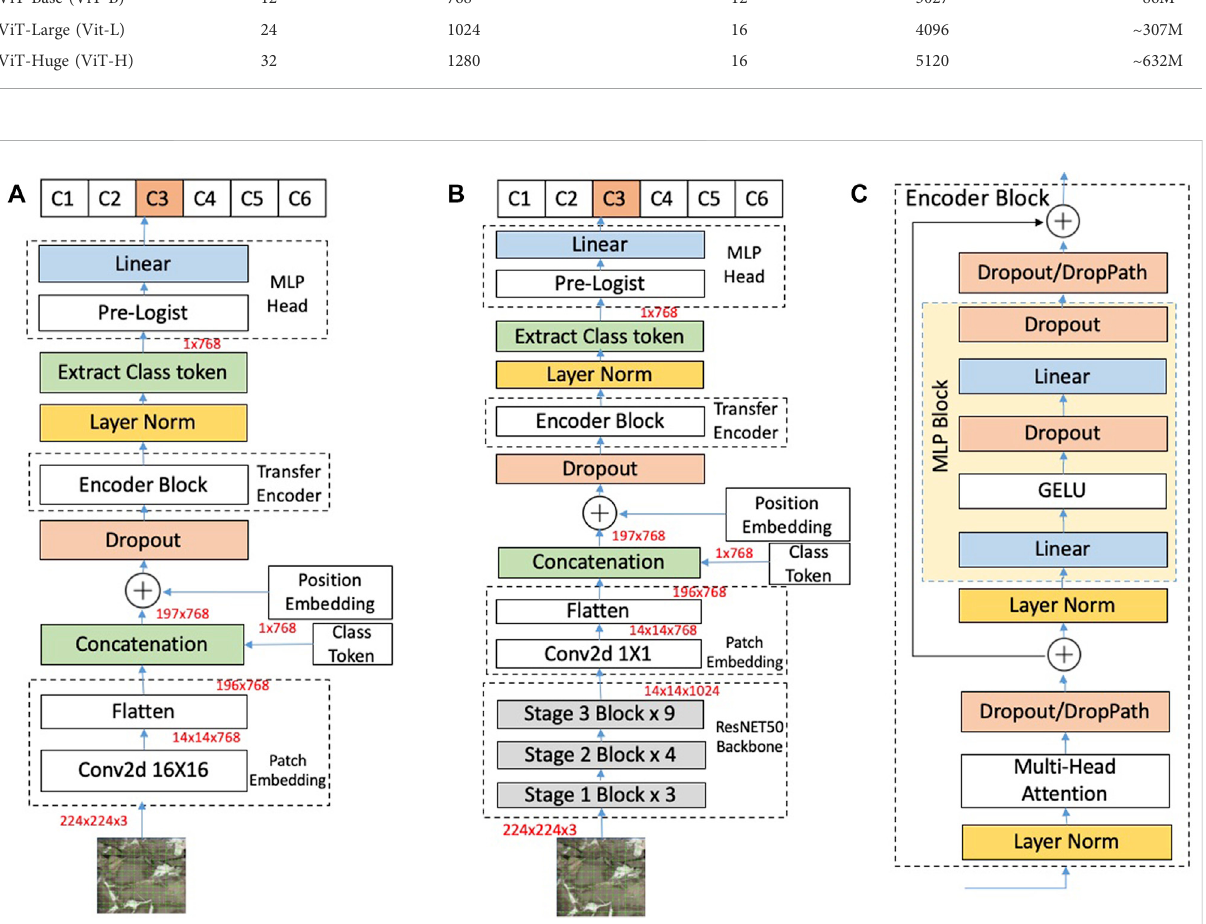
FIGURE 2 AnoverviewofVisionTransformerarchitecture: (A) FaciesViT, (B) thehybridResNetandViTarchitecture,and (C) theencoderblock.Theoutput layer is represented by Classes from C1 to C6 where C1: Argil, C2: Granit, C3: limestone, C4: Standstone lam, C5: Standstone mas, and C6: Siltstone. Since the input image belongs to limestone, this is highlighted in the output